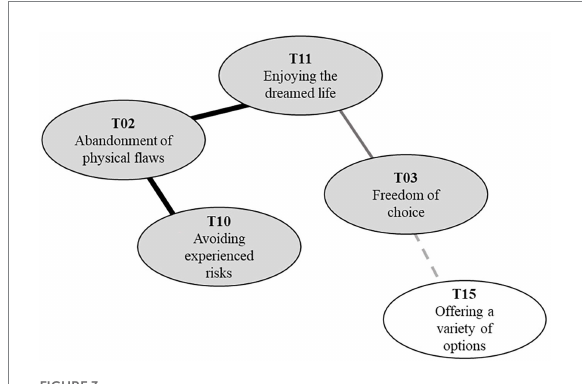
FIGURE 3 Negative perspective on avatar-based disability